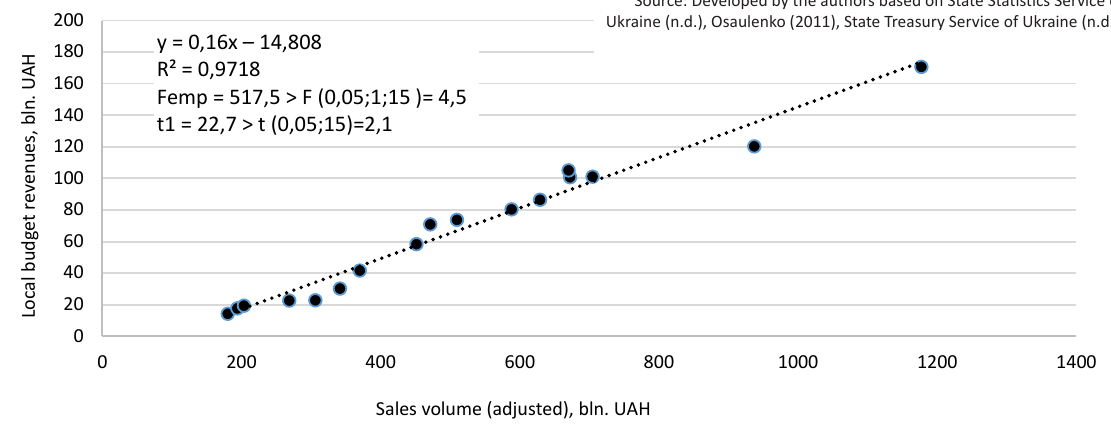
Figure 4. Linear relationship between the revenues of local budgets of Ukraine and the sales volume of small business, taking into account changes in legislation in 2008 and